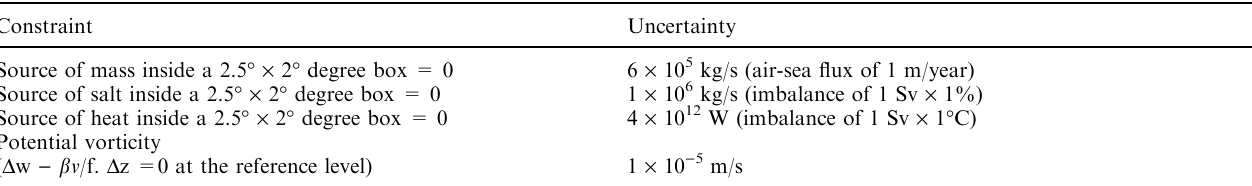
Table 2. Uncertainty in the dynamical conservation constrain imposed in the inverse model calculations Constraint